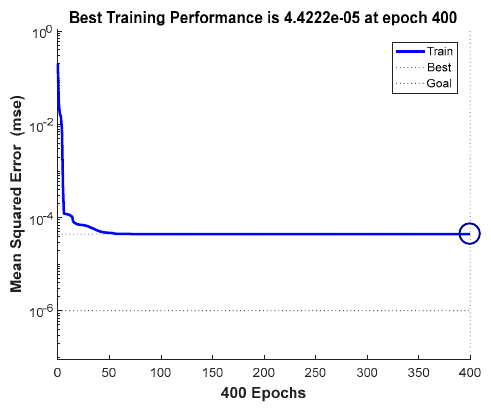
Figure 13. Convergence process of MSE.